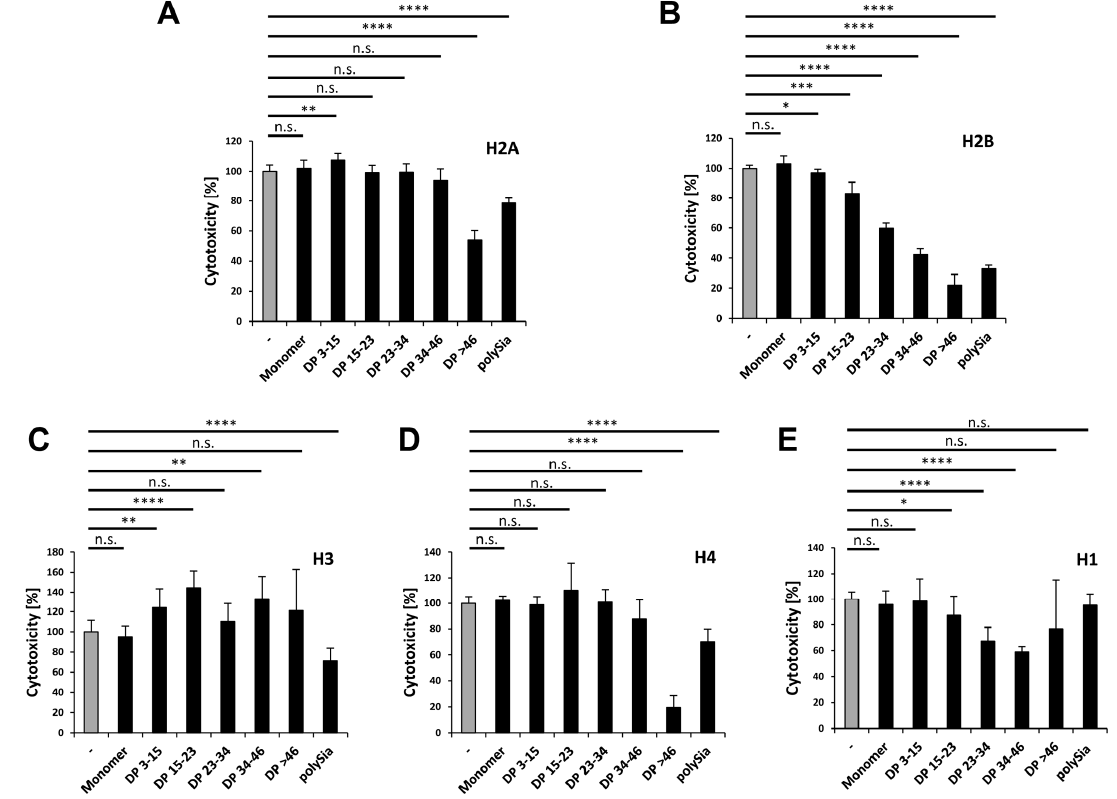
Figure 7. PolySia reduces the cytotoxicity of all histones. The cytotoxicity was determined for cells treated with each individual histone (60 μ g/mL) alone or together with different DPs of polySia (40 μ g/mL). The histone mediated cytotoxicity (gray bar) was set to 100%. All effects in presence of polySia are shown in black bars. ( A ) Histone H2A; ( B ) Histone H2B; ( C ) Histone H3; ( D ) Histone H4; and, ( E ) Histone H1. All of the experiments were performed three times independently. The statistical analysis was performed by t -test using Microsoft Excel: n.s., not significant; * p < 0.05; ** p < 0.01; *** p < 0.001; **** p < 0.0001.